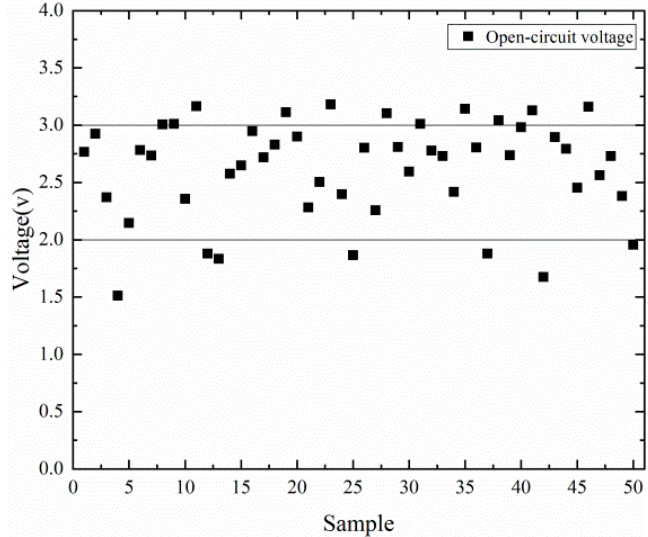
Figure 1. Voltage distribution of 50 retired batteries.